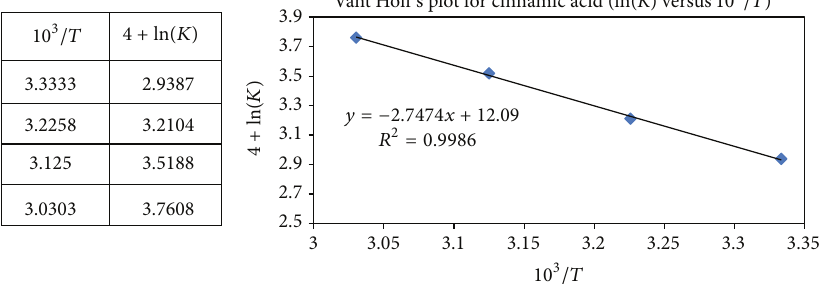
Figure 8: Vant Hoff’s plot of cinnamic acid (ln (𝐾) versus 10 3 / 𝑇 ). Kinetic study with [PEG-300] = 6.24 × 10 −1 moldm −3 .